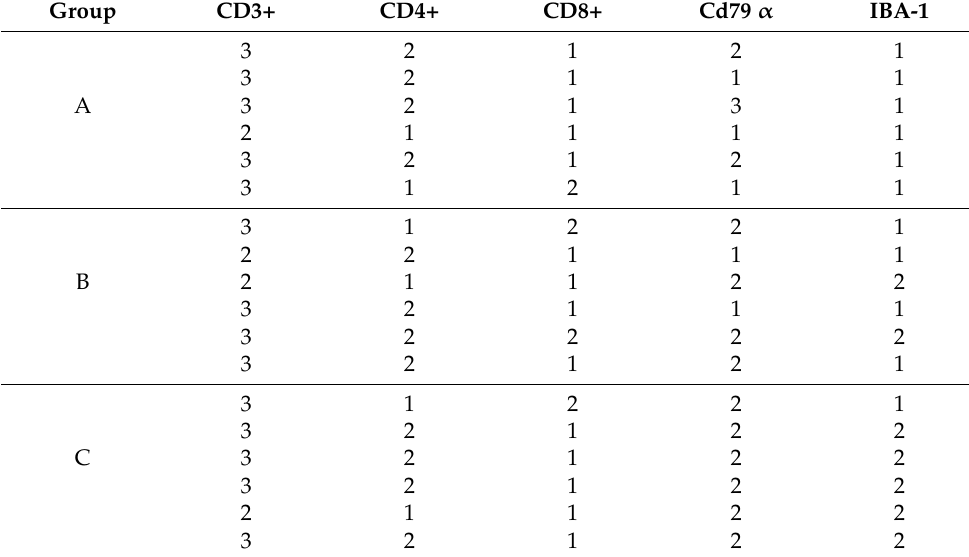
Table 2. Results of the immunohistochemical examination.